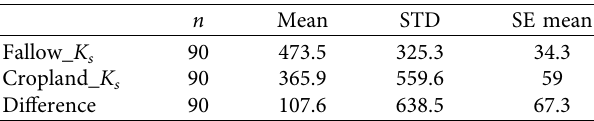
Figure 5: Histograms of K s (a) and Log K s (b) under fallow land. Table 1: Paired t -test for K s in cropland and K s in